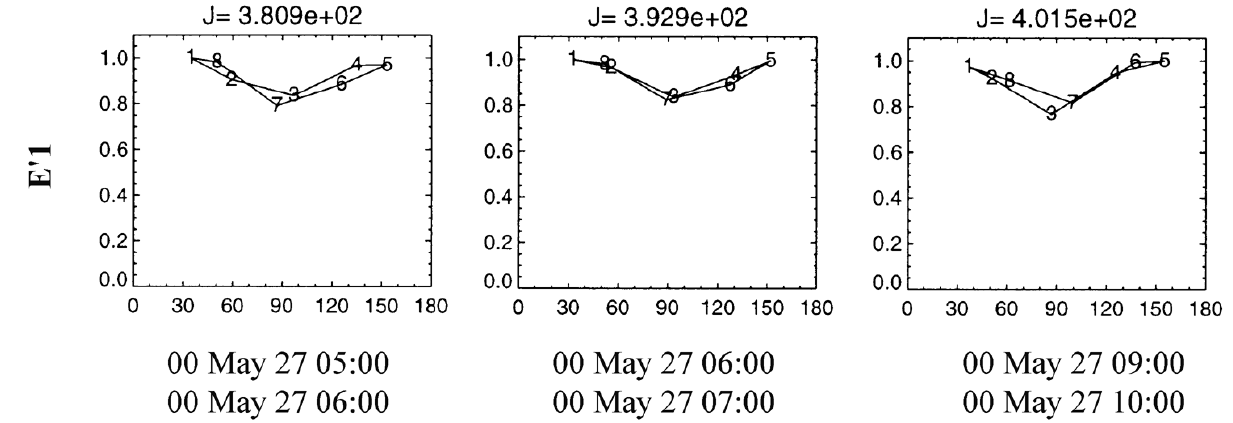
Fig. 3. Hourly-averaged electron pitch-angle distribution snapshots observed by ULYSSES inside the May 2000 high-latitude ICME (E 0 1: